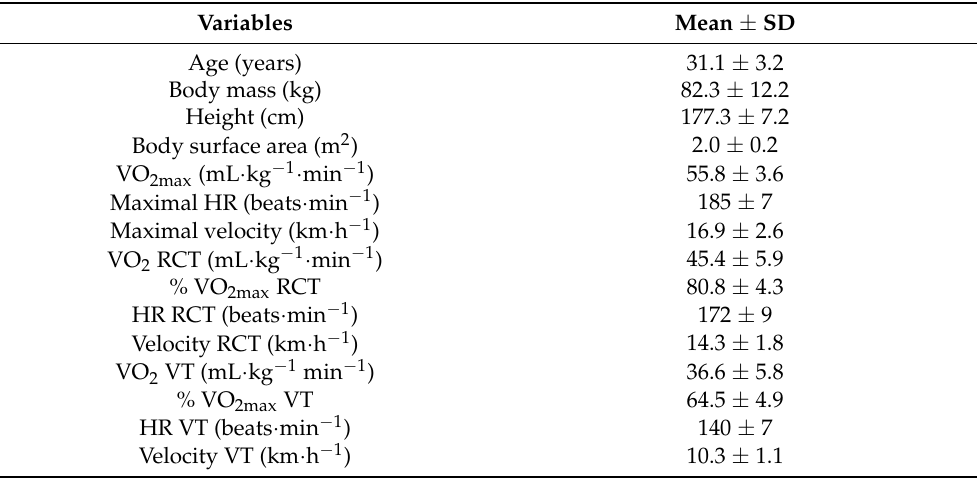
Table 1. Anthropometric characteristics and physiological values measured during the graded exercise